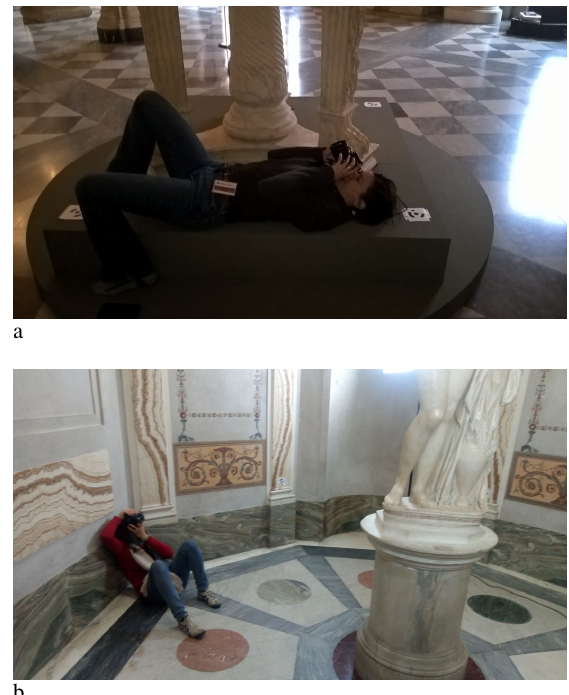
Figure 3. The problems with the shooting distance and the use of manual focusing when the distance and the lights in the Museum were favourable: (a) the tripod that was placed in a corner of the room with a good illumination; (b) the Capitoline Venus.